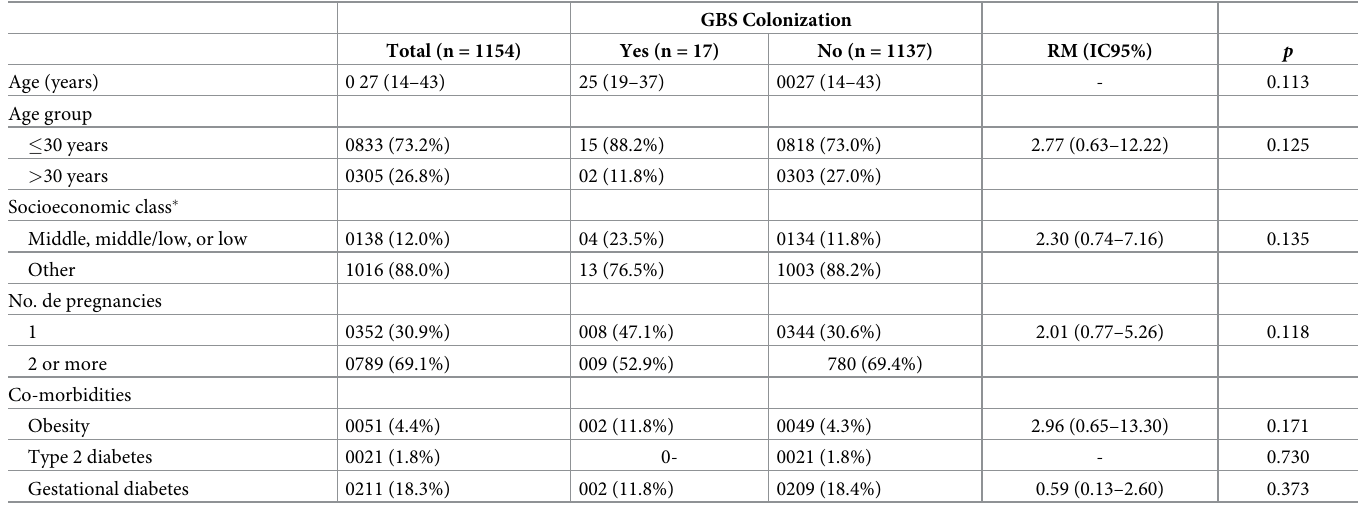
Table 1. Sociodemographic and obstetric characteristics of 1154 pregnant women classified according to the status of group B Streptococcus (GBS)